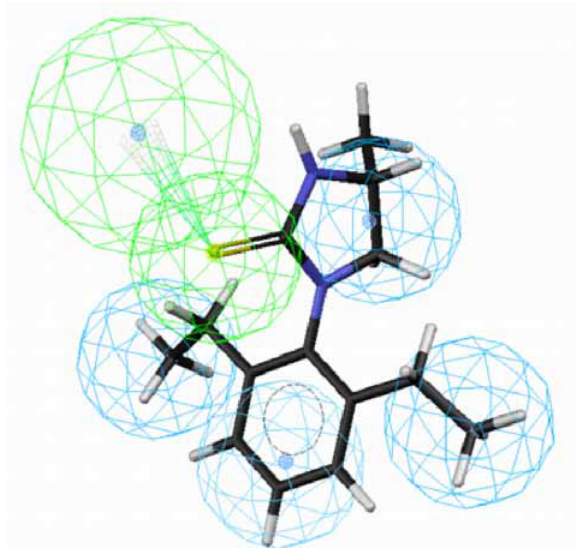
Figure 3. Mapping of 71 with ( S )-configuration to hypothesis 1, which contains an HpAr (blue), three HpAls (blue) and an HBAl